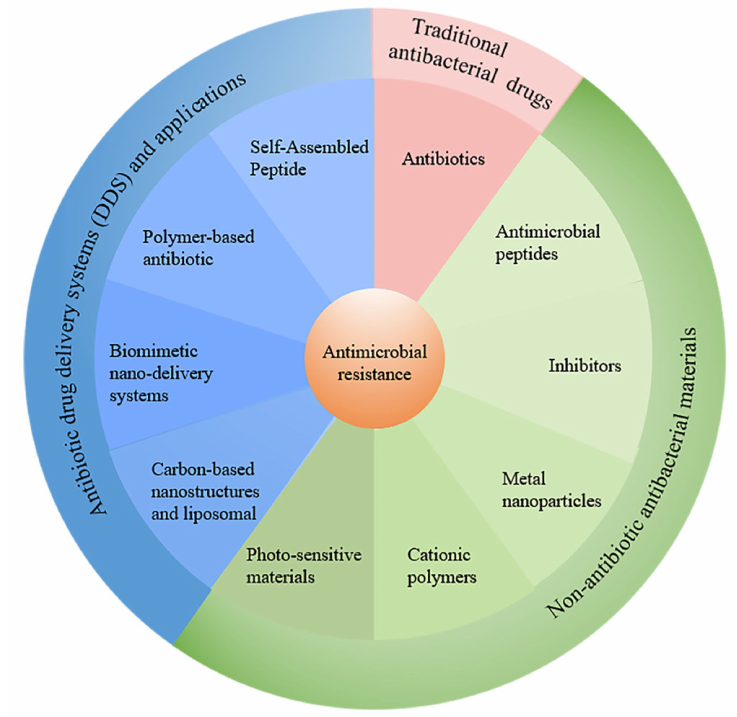
Figure 1. The recent strategies to combat antimicrobial resistance discussed in this